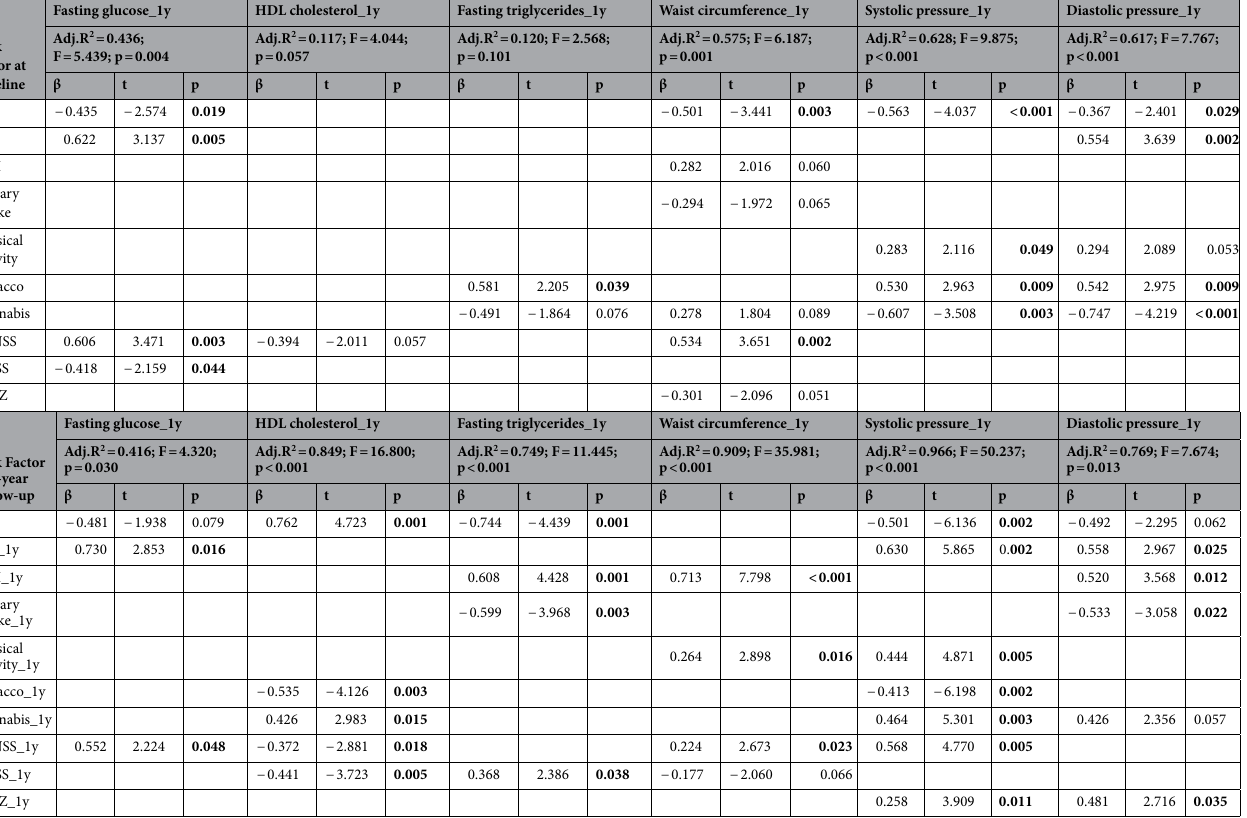
Table 4. Linear models for predicting metabolic parameters in patients with ROP after a 1-year follow-up. ROP recent-onset psychosis, Physical activity metabolic equivalents of task (MET)-min/week, Dietary intake Kcal/day, Tobacco daily consumption or not, Cannabis daily consumption or not; PANSS positive and negative syndrome scale, total score, CDSS Calgary depression scale for schizophrenia, eCPZ equivalent doses of chlorpromazine/day. Significant p values are shown in